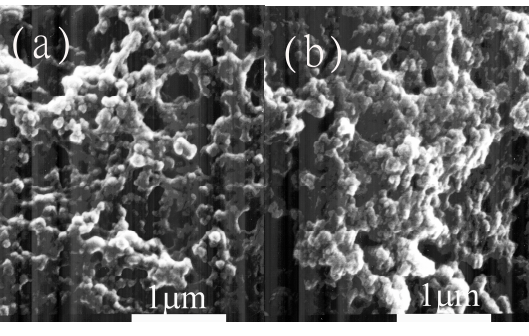
Figure 1. Scanning electron micrographs of biomimetic silica containing lipase from Pseudomonas cepacia . ( a ) Before; and ( b ) after